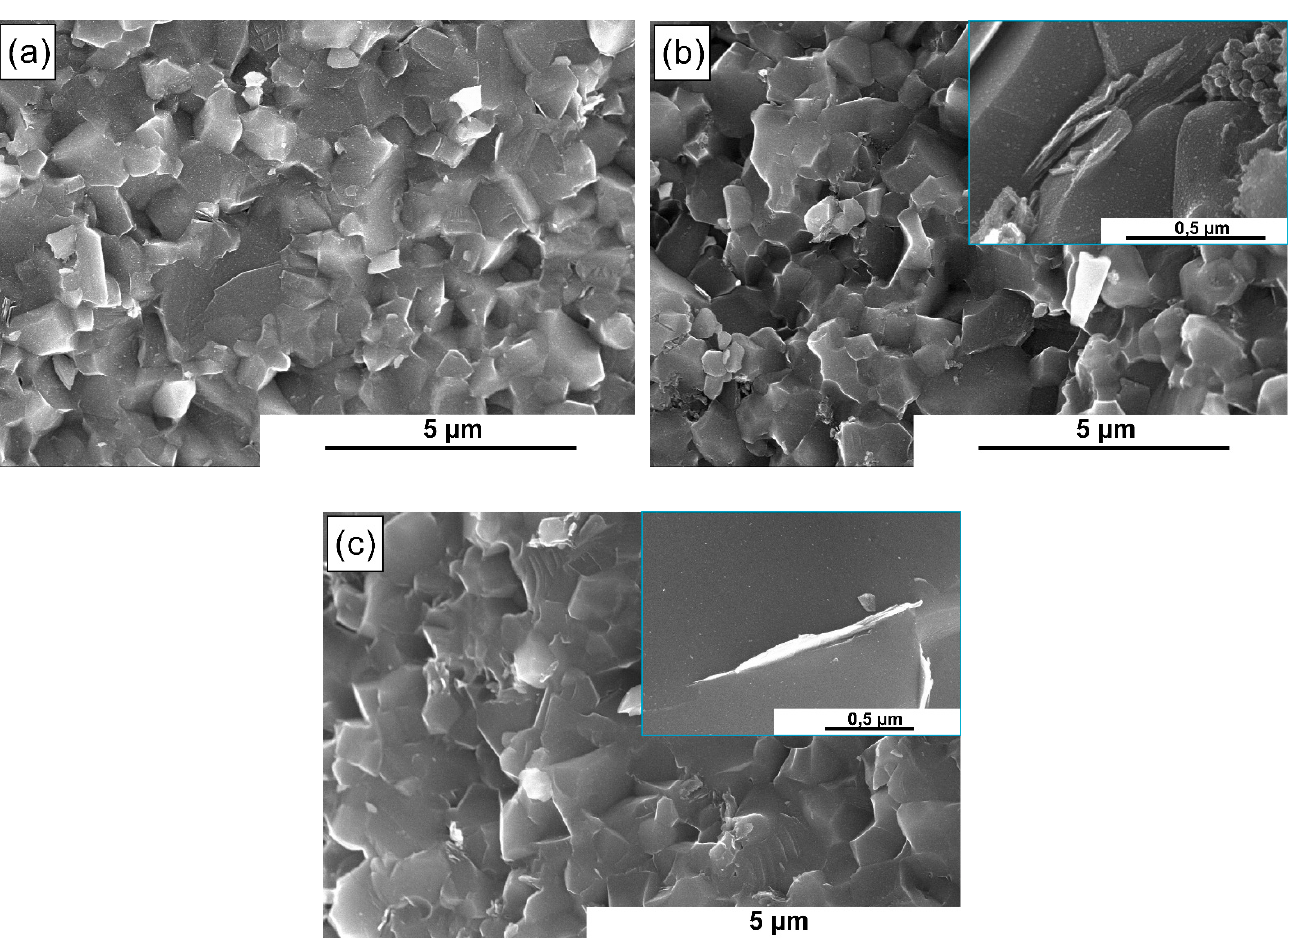
Figure 3. The relative density of obtained composites.